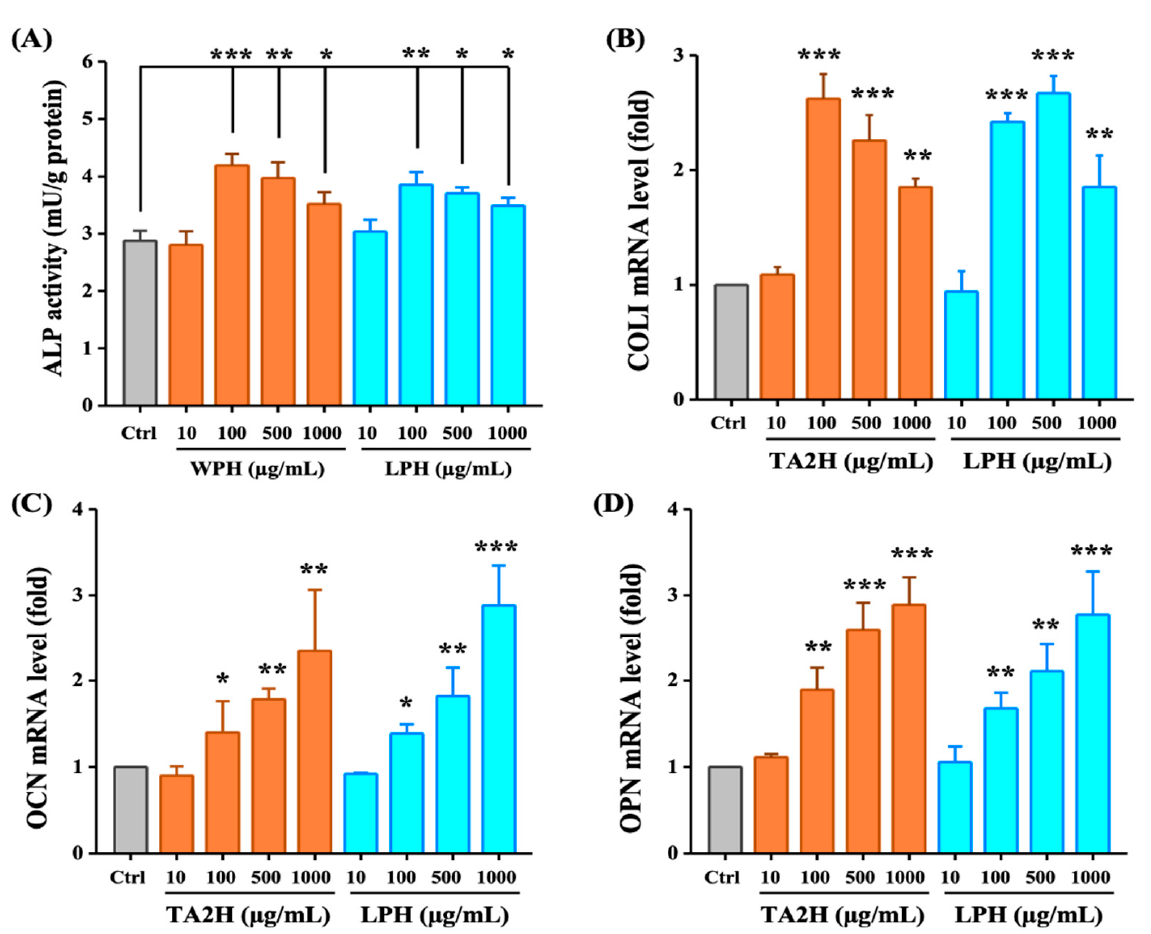
Figure 2. Effects of whey protein hydrolysates (TA2H and LPH) on cell differentiation in preosteoblast cells. MC3T3-E1 cells were seeded on six-well plates and were treated with growth medium containing 0 (control group), 10, 100, 500, and 1000 μ g/mL of TA2H and LPH for 3 days to detect ( A ) ALP activity and ( B ) mRNA level of COLI, and for 6 days to detect the mRNA level of ( C ) OCN and ( D ) OPN. Data are represented as the mean ± SEM, n = 6. *, **, and *** indicated p < 0.05, p < 0.01, and p < 0.001, as compared to the control group.